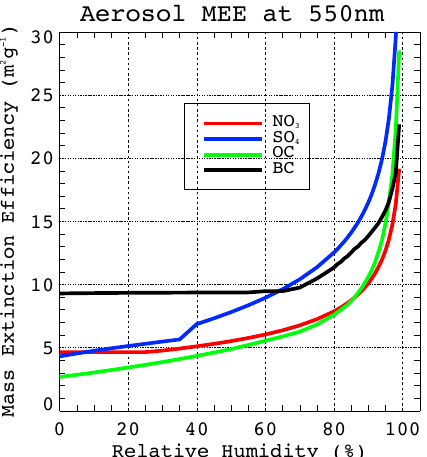
Figure 11. Mass extinction efficiency (MEE) at 550nm for indi- vidual aerosol components (units: m 2 g − 1 ) as a function of rela- tive humidity (RH). For SO 2 − , OC and BC, MEE is calculated 4 using the relationship of RH and size growth based on optical properties of aerosols and clouds (OPAC) (Hess et al., 1998). For NO − , MEE is calculated according to the work by A. Lacis (http: 3